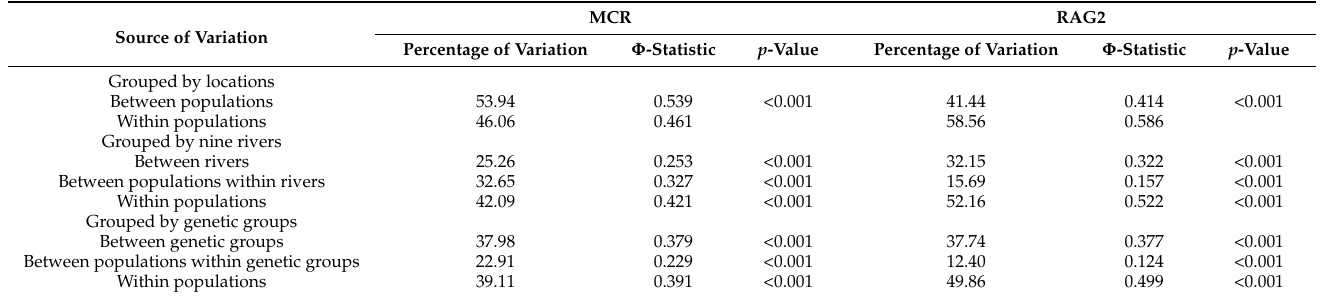
Table 2. Hierarchical population structure of Toxabramis houdemeri populations based on concatenated mitochondrial locus (MCR) and RAG2